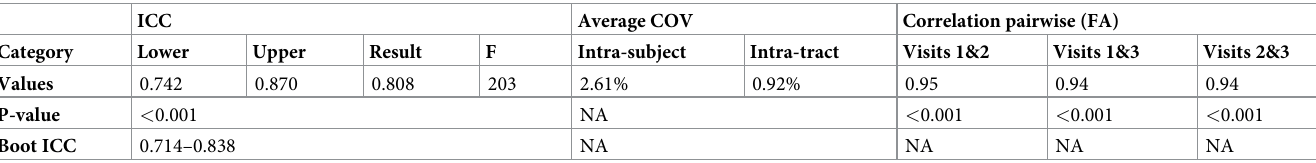
Reported results for mean intraclass correlation test (ICC), average coefficient of variation (COV) for within tracts and within-subject measurements, and pairwise FA correlation. ICC, COV and correlation analyses were carried on all 47 tracts, the average is reported. Boot ICC are results of the confidence interval following a bootstrap test on our